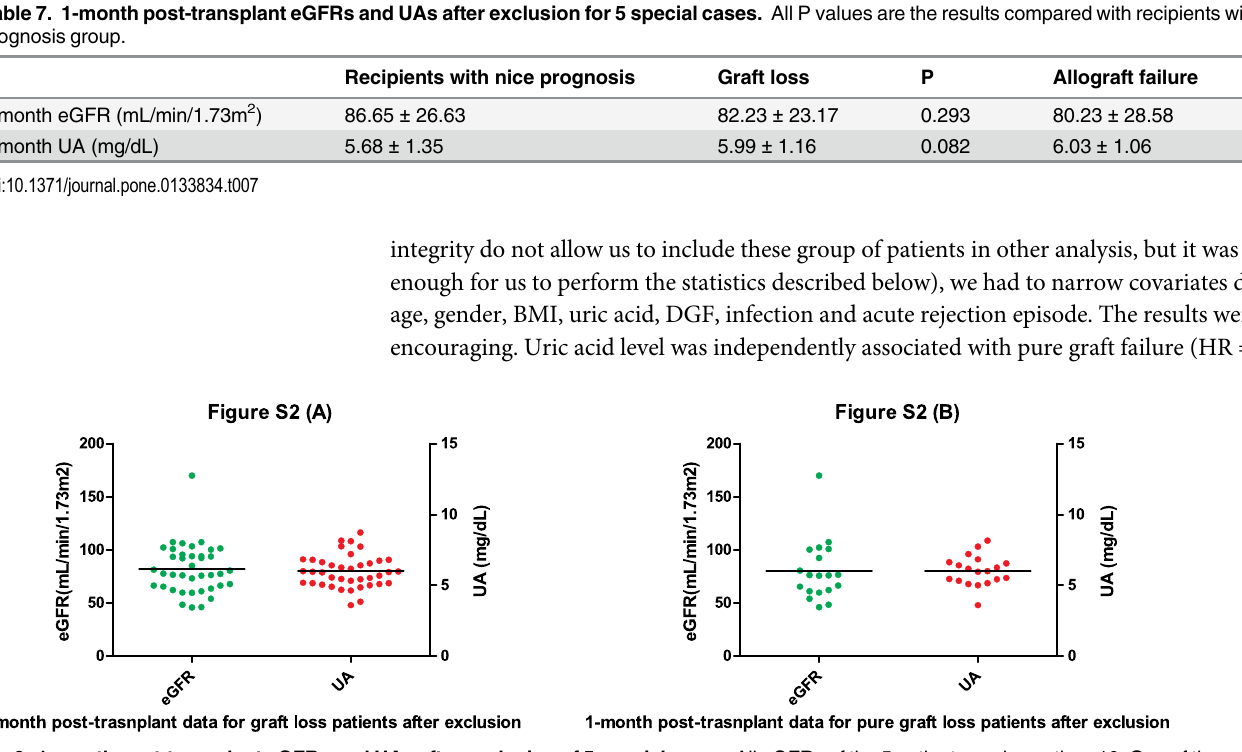
Fig 3. 1-month post-transplant eGFRs and UAs after exclusion of 5 special cases. All eGFRs of the 5 patients are lower than 10. One of them was having an acute rejection when tested for eGFR, the other 4 patients were experiencing DGF, 2 of them returned to dialysis eventually and the other 2 had recovered 2 months later. (A) The group of recipients went through allograft failure or death eventually. (B) The group of patients only suffered allograft failure.